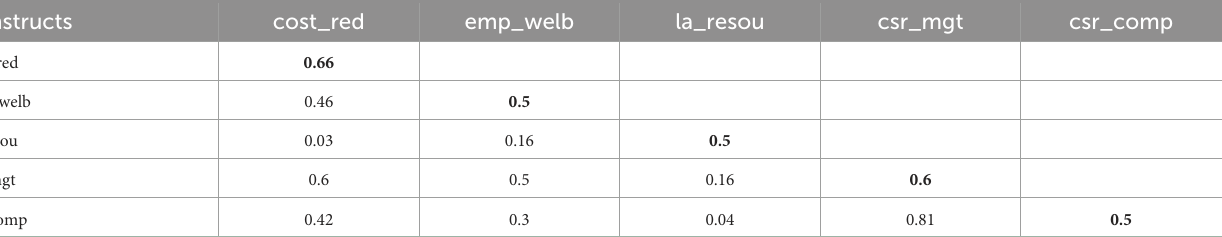
TABLE 3 Discriminant